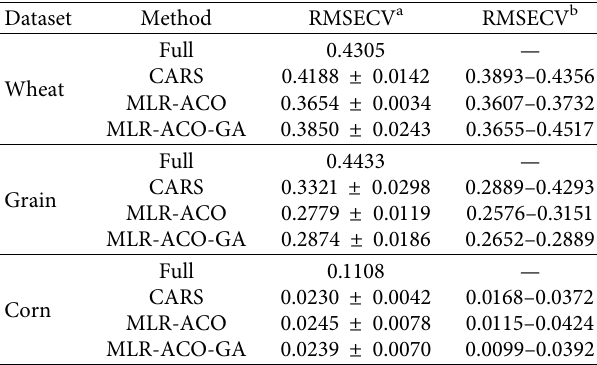
Table 4: Results of PLS modeling with diferent methods on diferent